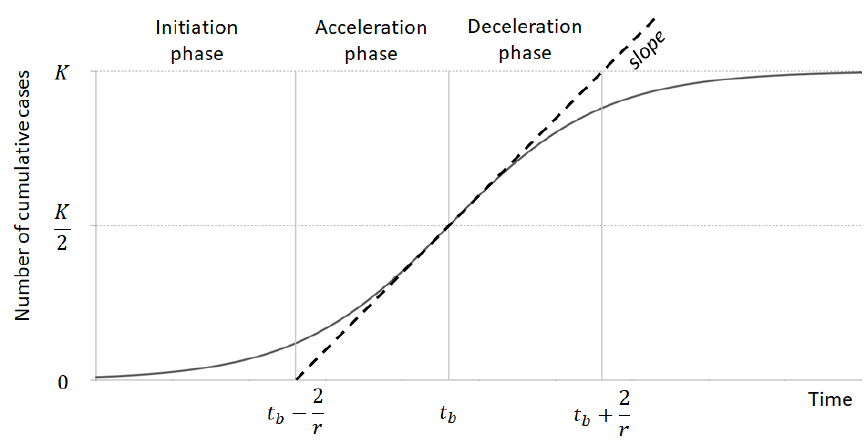
Figure 1. Example of a logistic curve representing the cumulative number of cases assessed over time (modified from [16]).